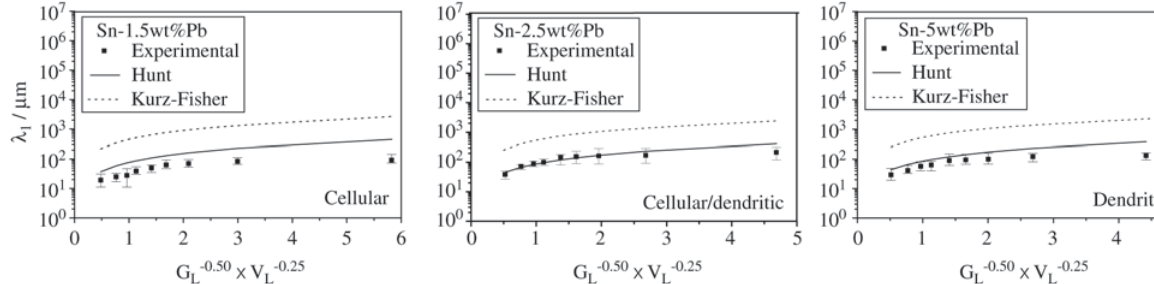
= 39 mm, V = 1.04 mm/s, • T = 1.8 K/s; b) 1 L